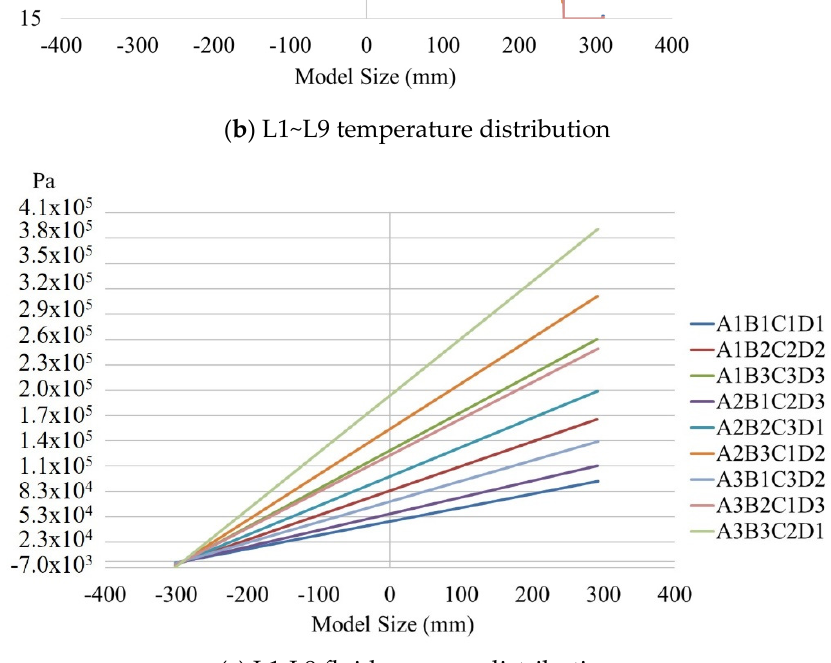
Table 5. Average of factors at three levels.